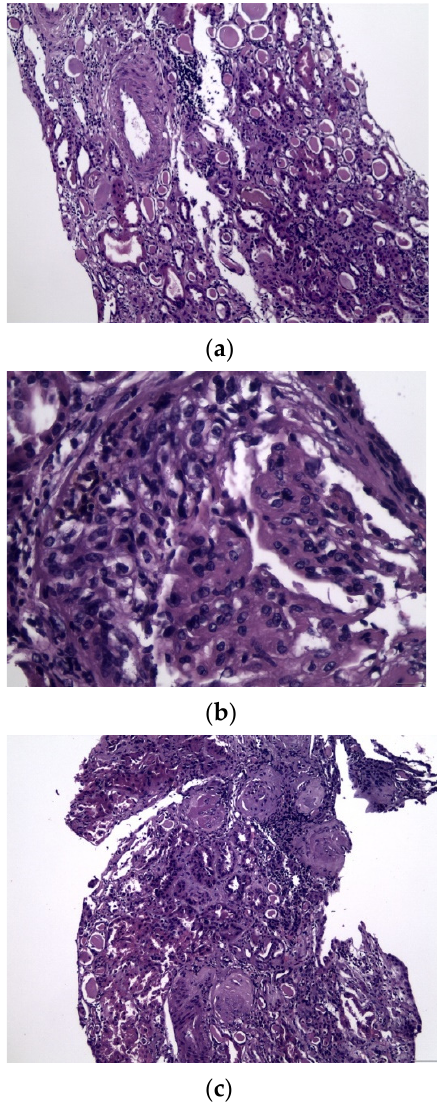
Figure 2. ( a – c ) Pauci-immune crescentic sclerotic glomerulonephritis: ( a ) focus of thyroidization of renal parenchyma; ( b ) glomerulus with a large cellular crescent; ( c ) globally sclerosed glomeruli in a moderate-to-severe fibrotic interstitium.